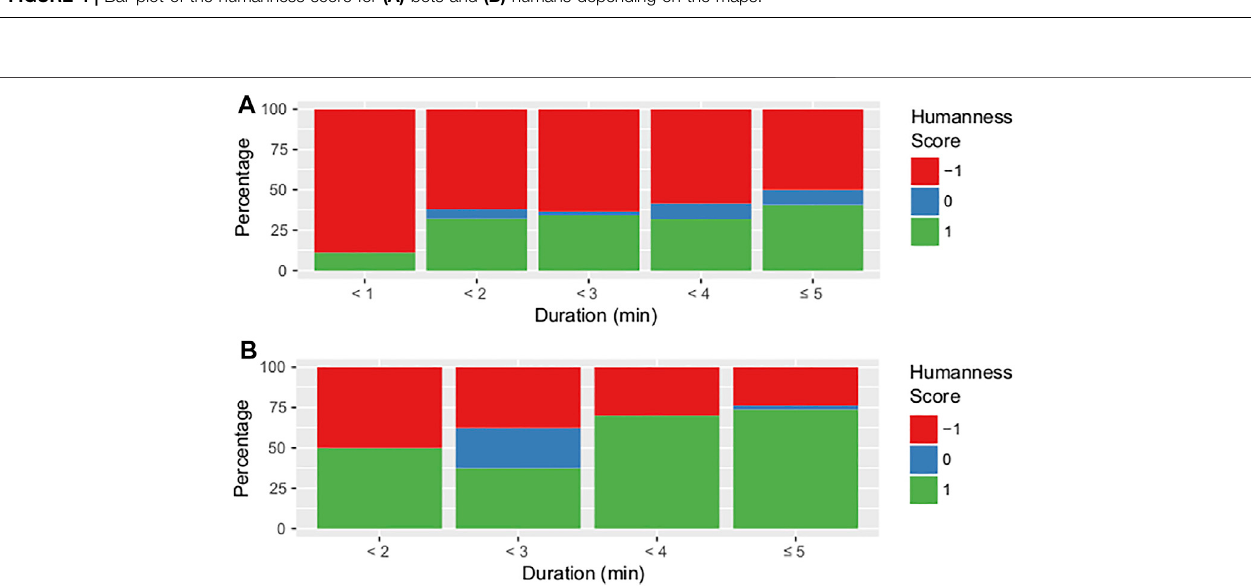
FIGURE 5 | Bar plot of the humanness score for (A) bots and (B) humans depending on the match duration (in minutes).